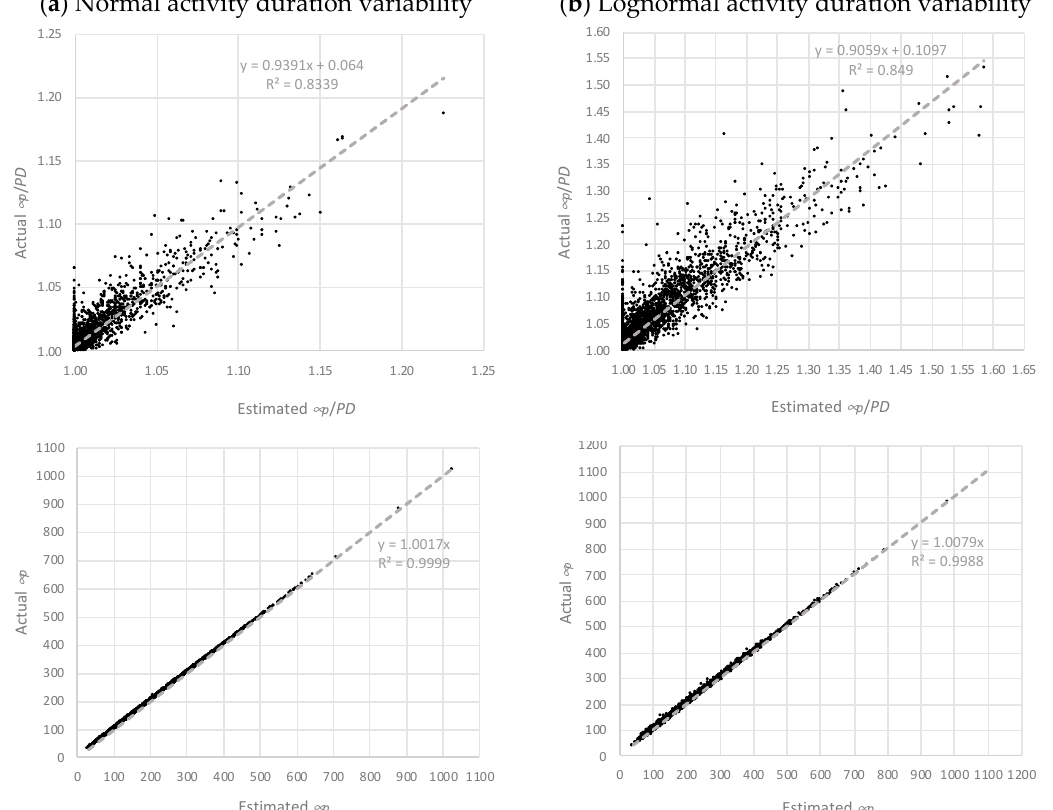
Figure 2. Dataset I μ p regressions with normal ( a ) and lognormal ( b ) activity duration variability.